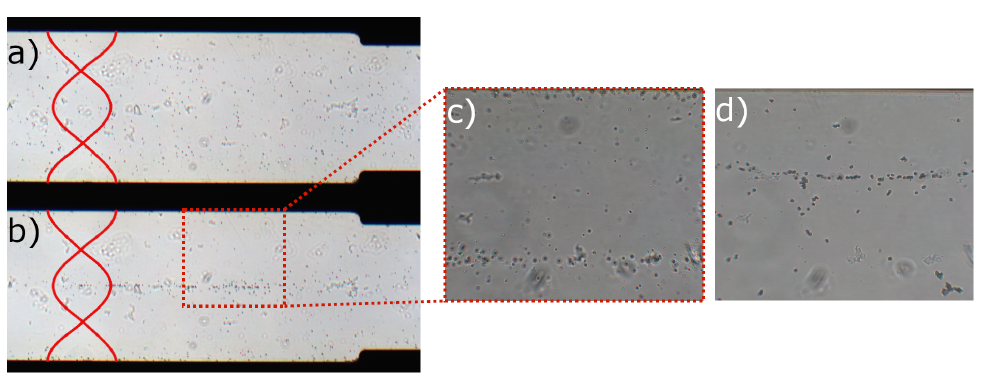
Figure 3. The spreading of droplets in the microchannel ( a ) before ultrasound actuation and ( b ) after ultrasound actuation. The red lines show the ultrasonic standing waves and the location of pressure nodes (where the lines cross each other) and pressure antinodes (where the red lines are at maximum distance from each other). ( c ) The droplets relocate to pressure antinodes, as compared to ( d ) polyamide beads in pressure nodes at the same